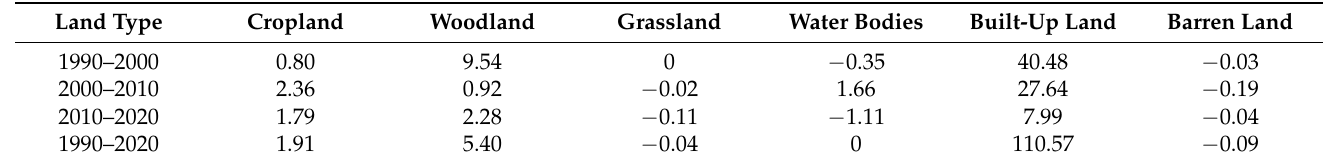
Table 2. Land use dynamic attitude in the Tarim River Basin, 1990–2020